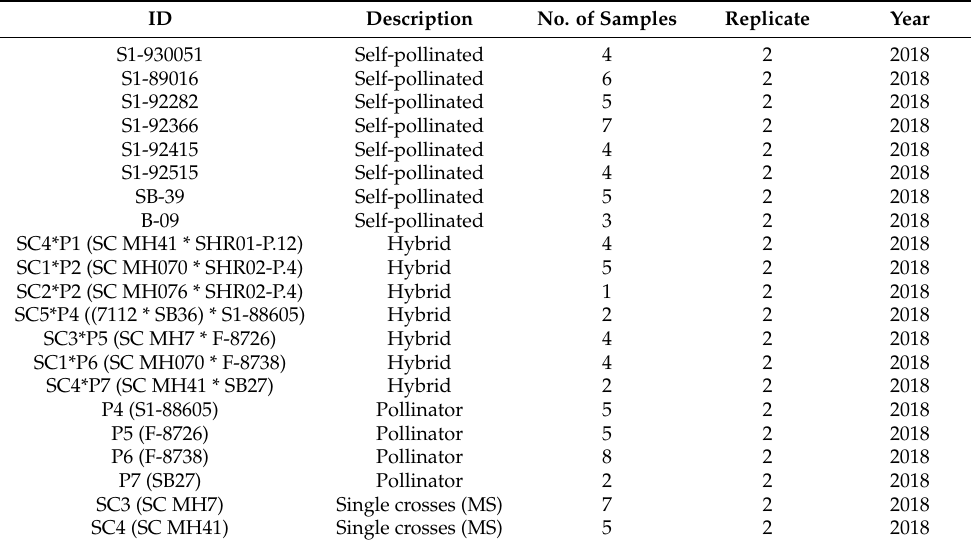
Table 1. Description of plant material from SBSI, Iran used for phenotyping and SNP discovery. * indicates the